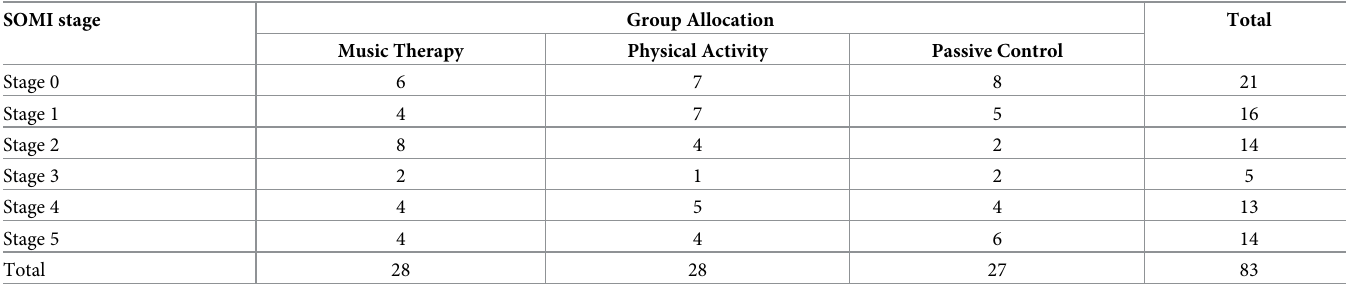
Table 3. Group allocation of SOMI